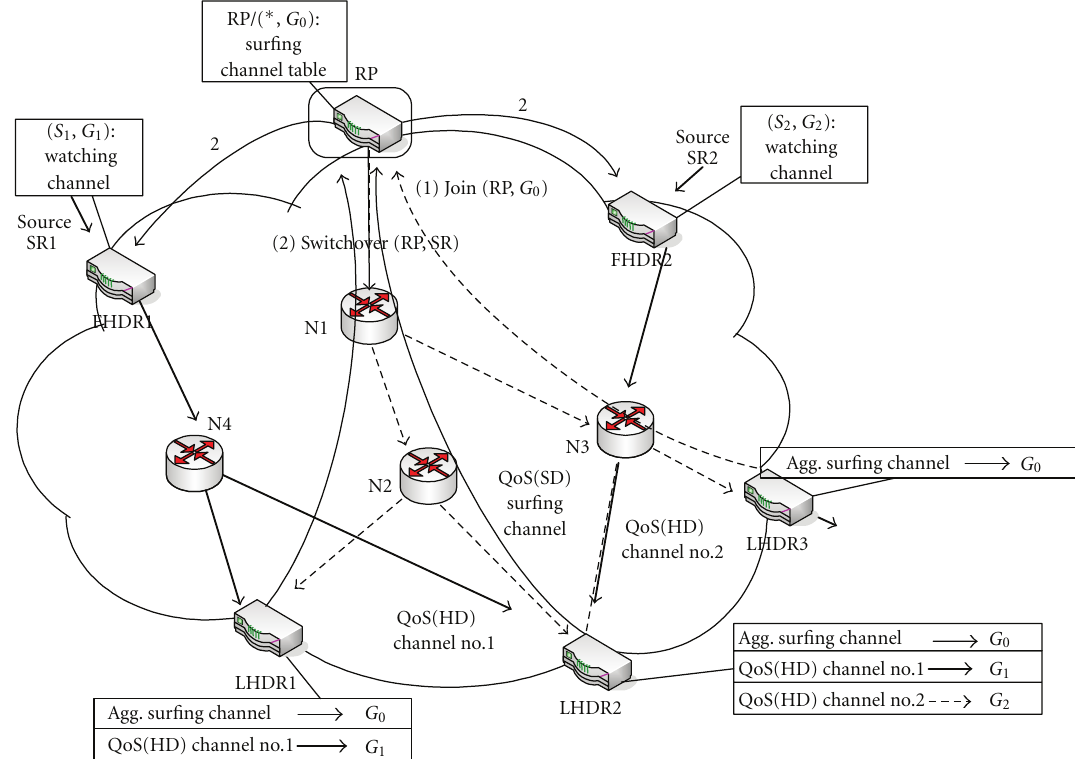
Figure 4: IPTV channel delivery through HT-ERM